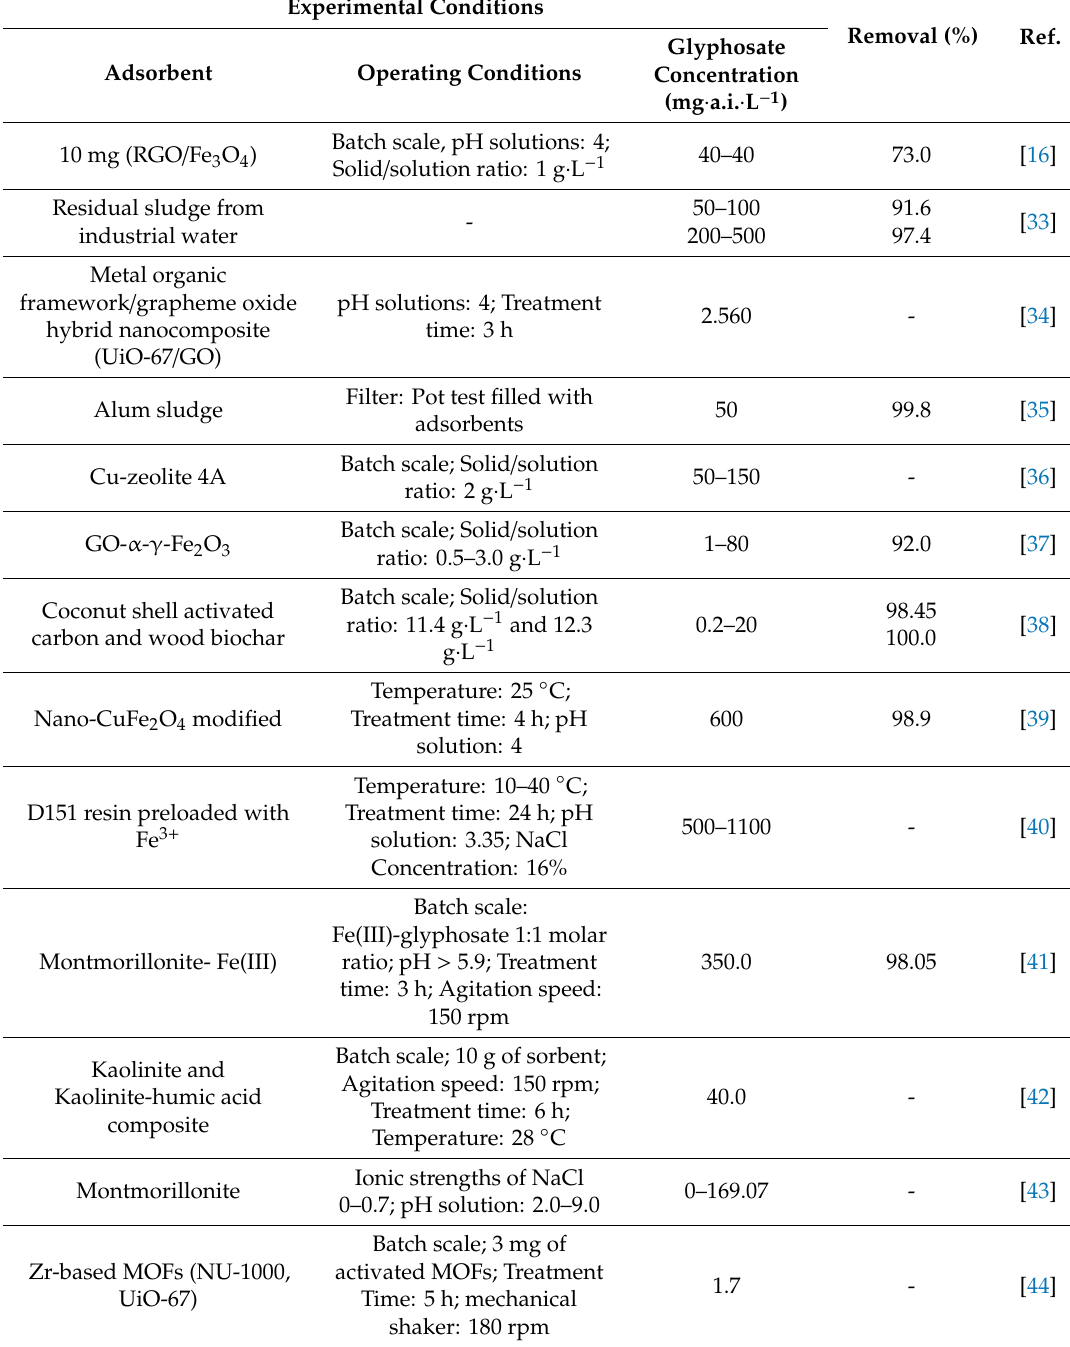
Table 2. Removal of glyphosate from water polluted by adsorption